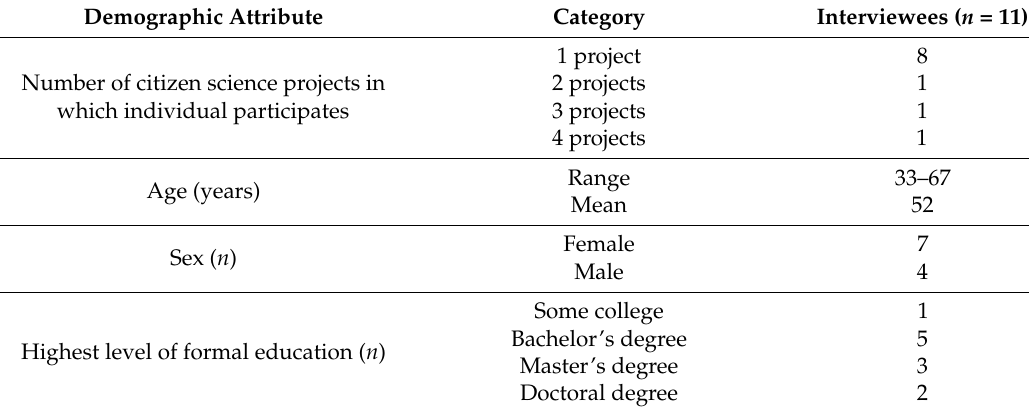
Table 4. Demographic data of